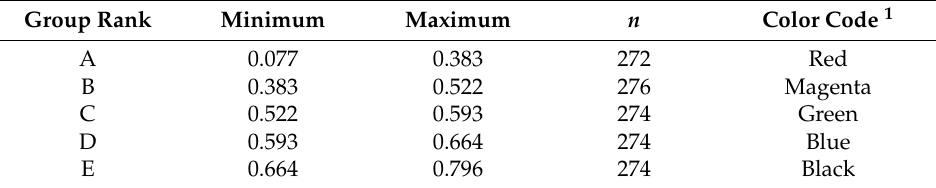
1 Color code used in figure 2 representing the group ranks.